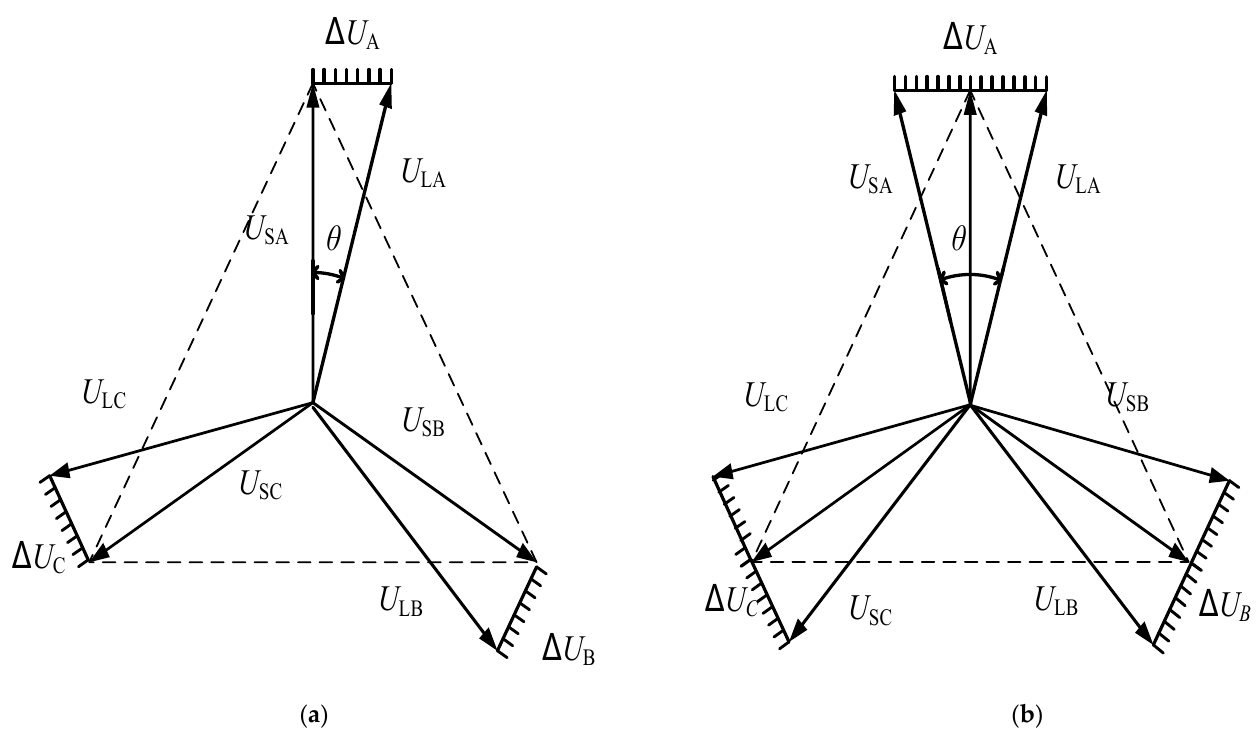
Figure 4. Voltage phasor of PST. ( a ) The asymmetric PST, ( b ) Symmetric PST.